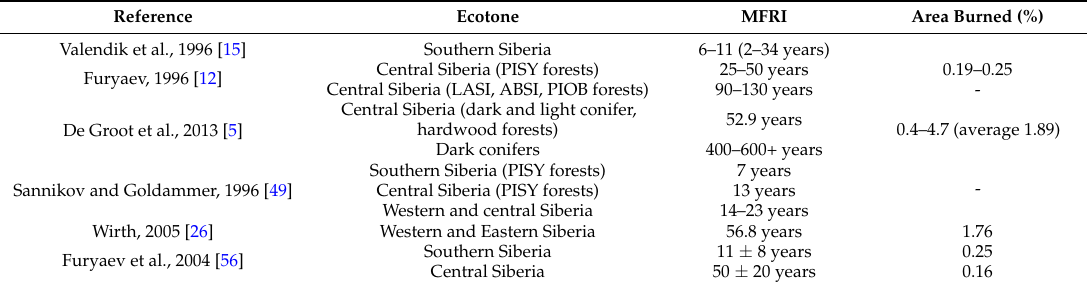
Table 3. Mean fire return interval (MFRI) varies by region and forest type. The shortest MFRI is found in pine stands and is approximately 10 years, while the longest MFRI in dark conifer stands can be upward of 640 years. Conard and Ivanova [3] suggest 50 years as a default average MFRI for Russian boreal forest when the exact MFRI for the ecotone is not